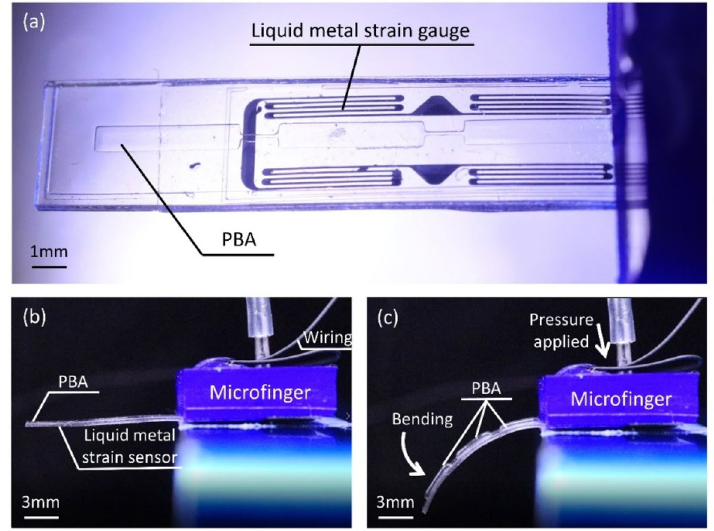
Figure 2. Developed microfinger (12 mm long, 3 mm wide, 490 μm thick) for active force sensing of a pill bug. ( a ) Photograph of a top view of microfinger. ( b ) Side view of an initial state of a microfinger. ( c ) Side view of bending motion of a